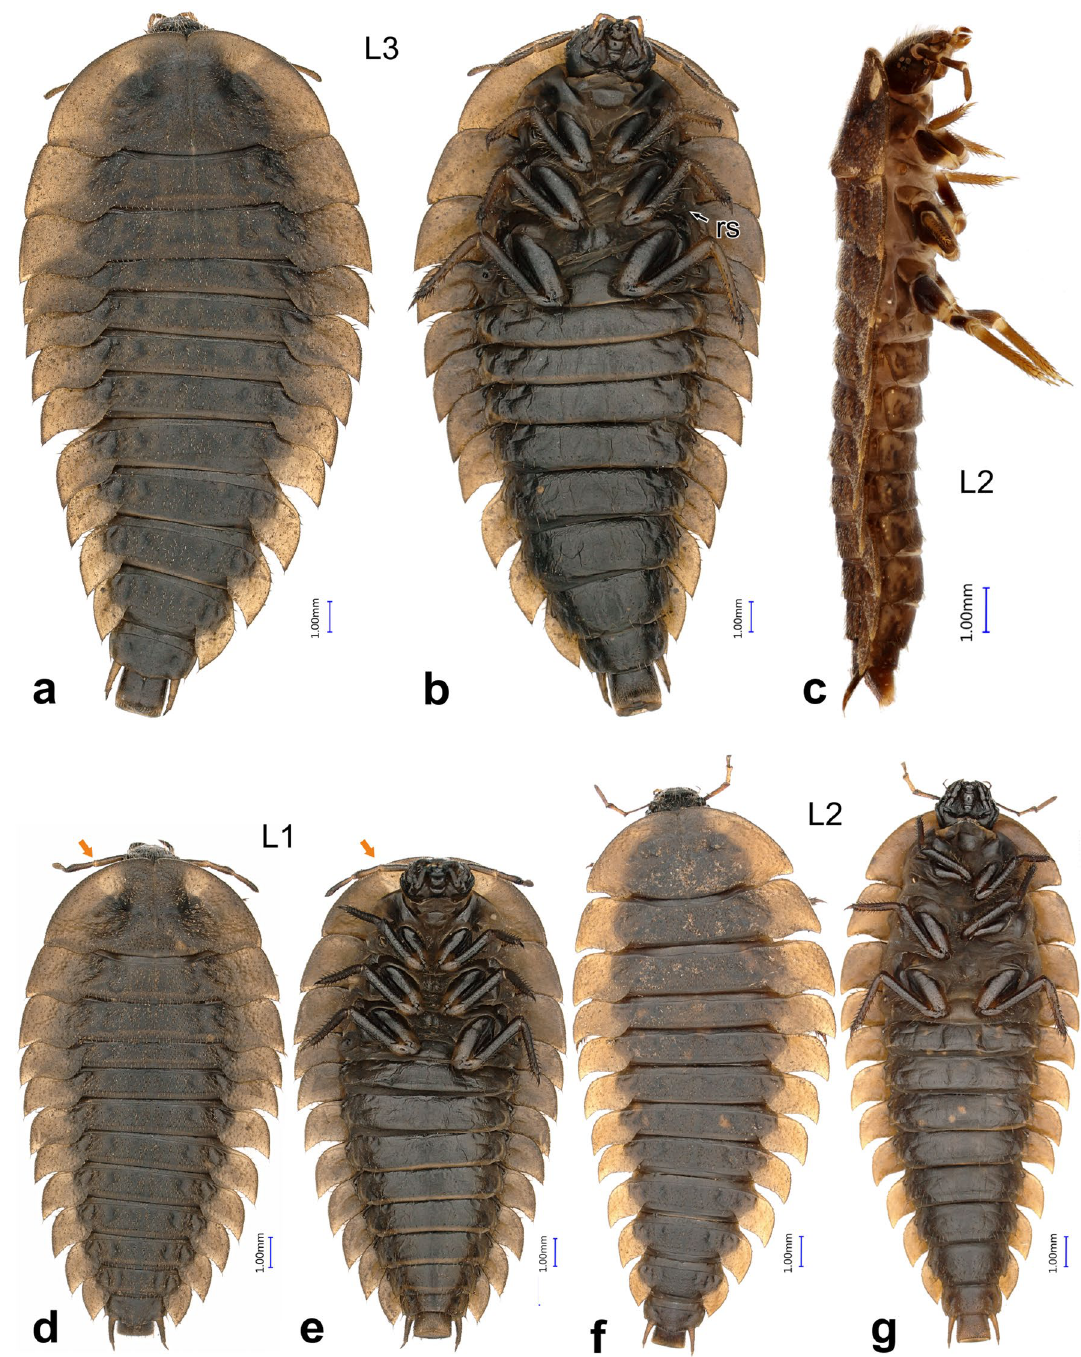
Figure 3. Heterotemna tenuicornis (Brullé, 1836), habitus of larvae: ( a , b ) third instar larva, dorsal and ventral view; ( c ) second instar larva, lateral view; ( d , e ) first instar larva, dorsal and ventral view; ( f , g ) second instar larva, dorsal and ventral view. Abbreviations: rs rudimentary sensorium, bearing several sclerotized pores surrounded by narrow, sclerotized ring (Fig. 6f), externally with a wide unsclerotized area. More apically, antennomere II with three additional smaller sensilla (Figs. 4a, 5a, 6f). Anterior margin of protergum medially with narrow emargination (Fig. 8i). Rudimentary spiraculum present on metasternum (Fig. 3b). Paratergites of meso- and metathorax and abdominal segments I–VIII resembling the shape of pig ears, constricted posteriorly between tergite and paratergite, with apex pointed posteriorly (Figs. 3a, 4c, g). Ventrite II on abdomen entire, not subdivided into three sclerites (Fig. 3b).